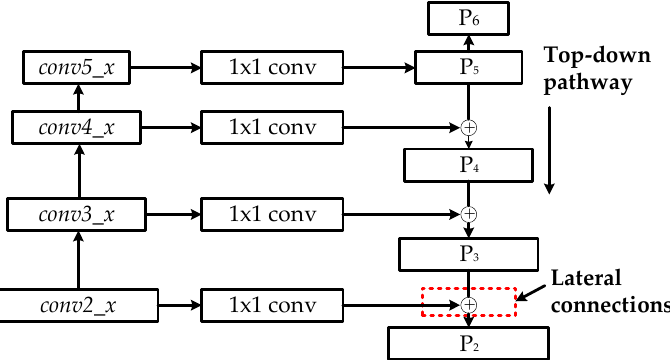
Figure 6. Architecture of feature fusion in the multiscale defect-detection network.